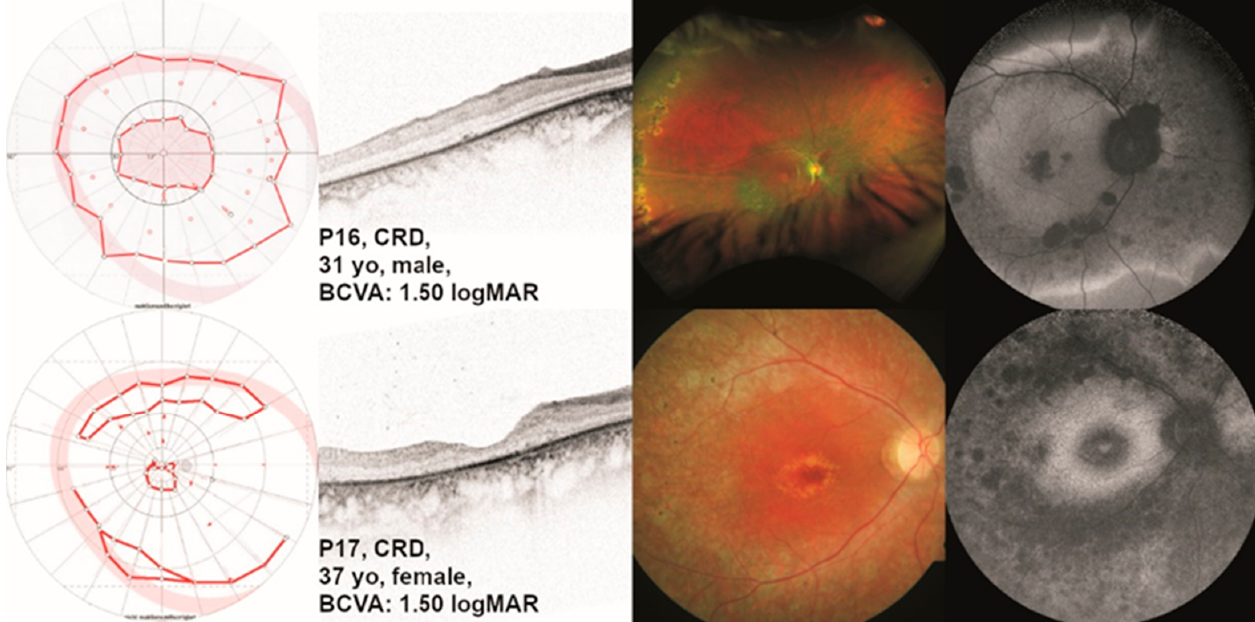
Figure 5. Clinical presentation of patients P16 and P17 with TULP1 -associated cone-rod dystrophy (CRD). The results of kinetic visual field (VF) testing, optical coherence tomography (OCT), fundus photography, and fundus autofluorescence (FAF) imaging are shown from left to right. Gender and best-corrected visual acuity (BCVA) are also listed. Note the visual field in patient P16 with a large central scotoma. Additionally, note that the mid-peripheral and peripheral retina is relatively preserved on Optos and FAF imaging in this patient. Patient P17 shows retinal dystrophy with macular involvement.